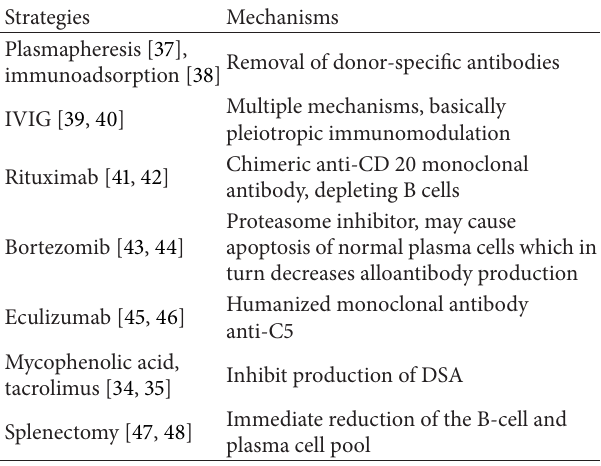
Table 2: Strategies to treat